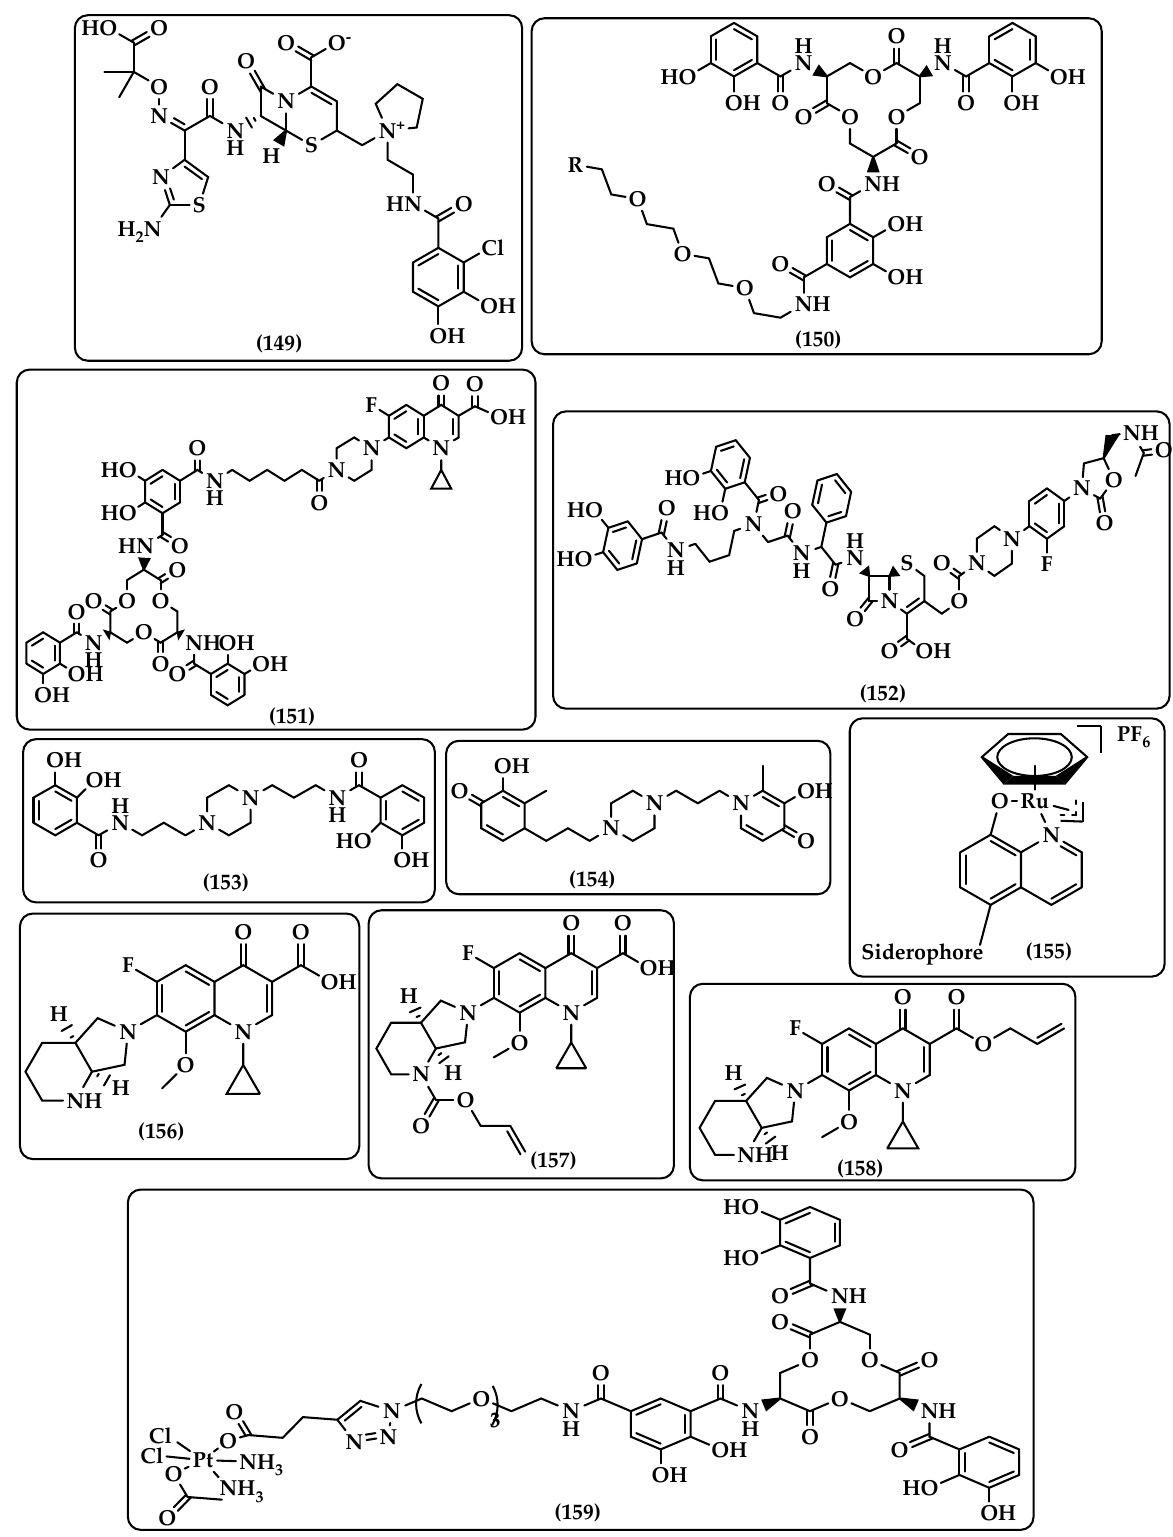
Figure 15. Chemical structure of, Cefiderocol (CFDC) ( 149 ), siderophore-antibiotic conjugates ( 150 ), enterobactin-ciprofloxacin conjugate ( 151 ), oxazolidinone-cephalosporin-bis-catechol-based siderophore conjugates ( 152 ), piperazine-based siderophore mimetics ( 153 ), ( 154 ), siderophore-linked ruthenium catalysts ( 155 ), moxifloxacin ( 156 ), N-moxi ( 157 ), C-moxi ( 158 ), and cisplatin prodrug- enterobactin ( 159